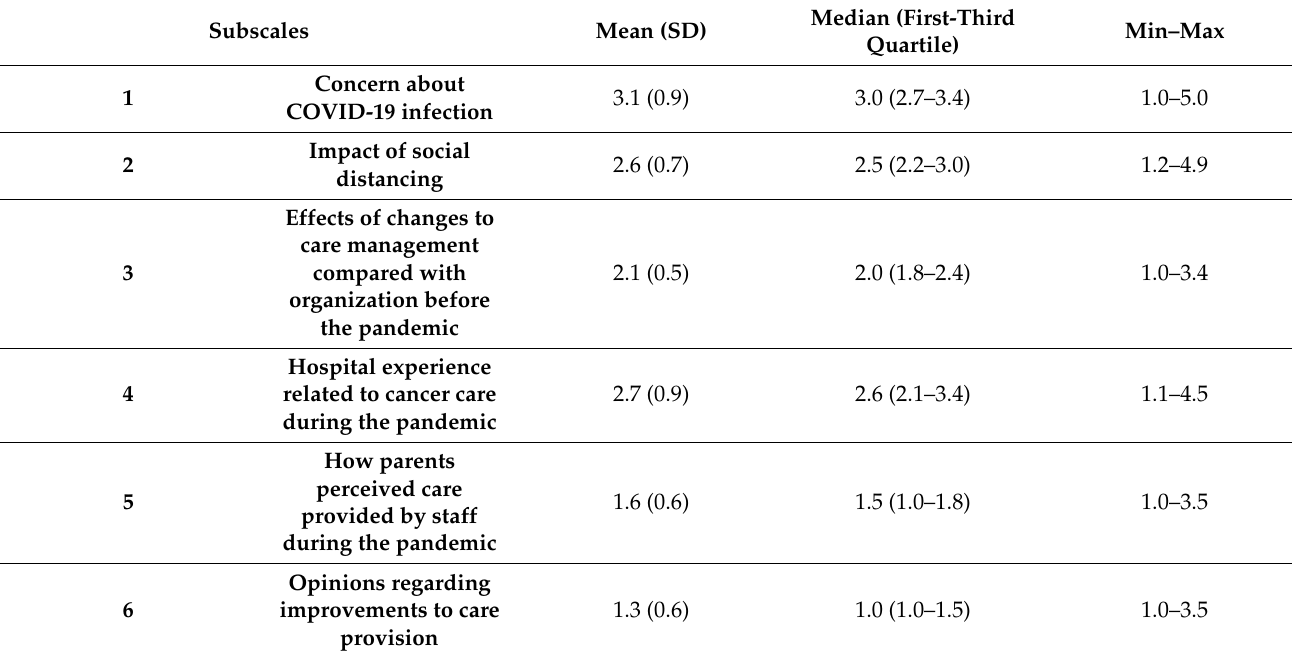
Table 1. Six subscales of questionnaire